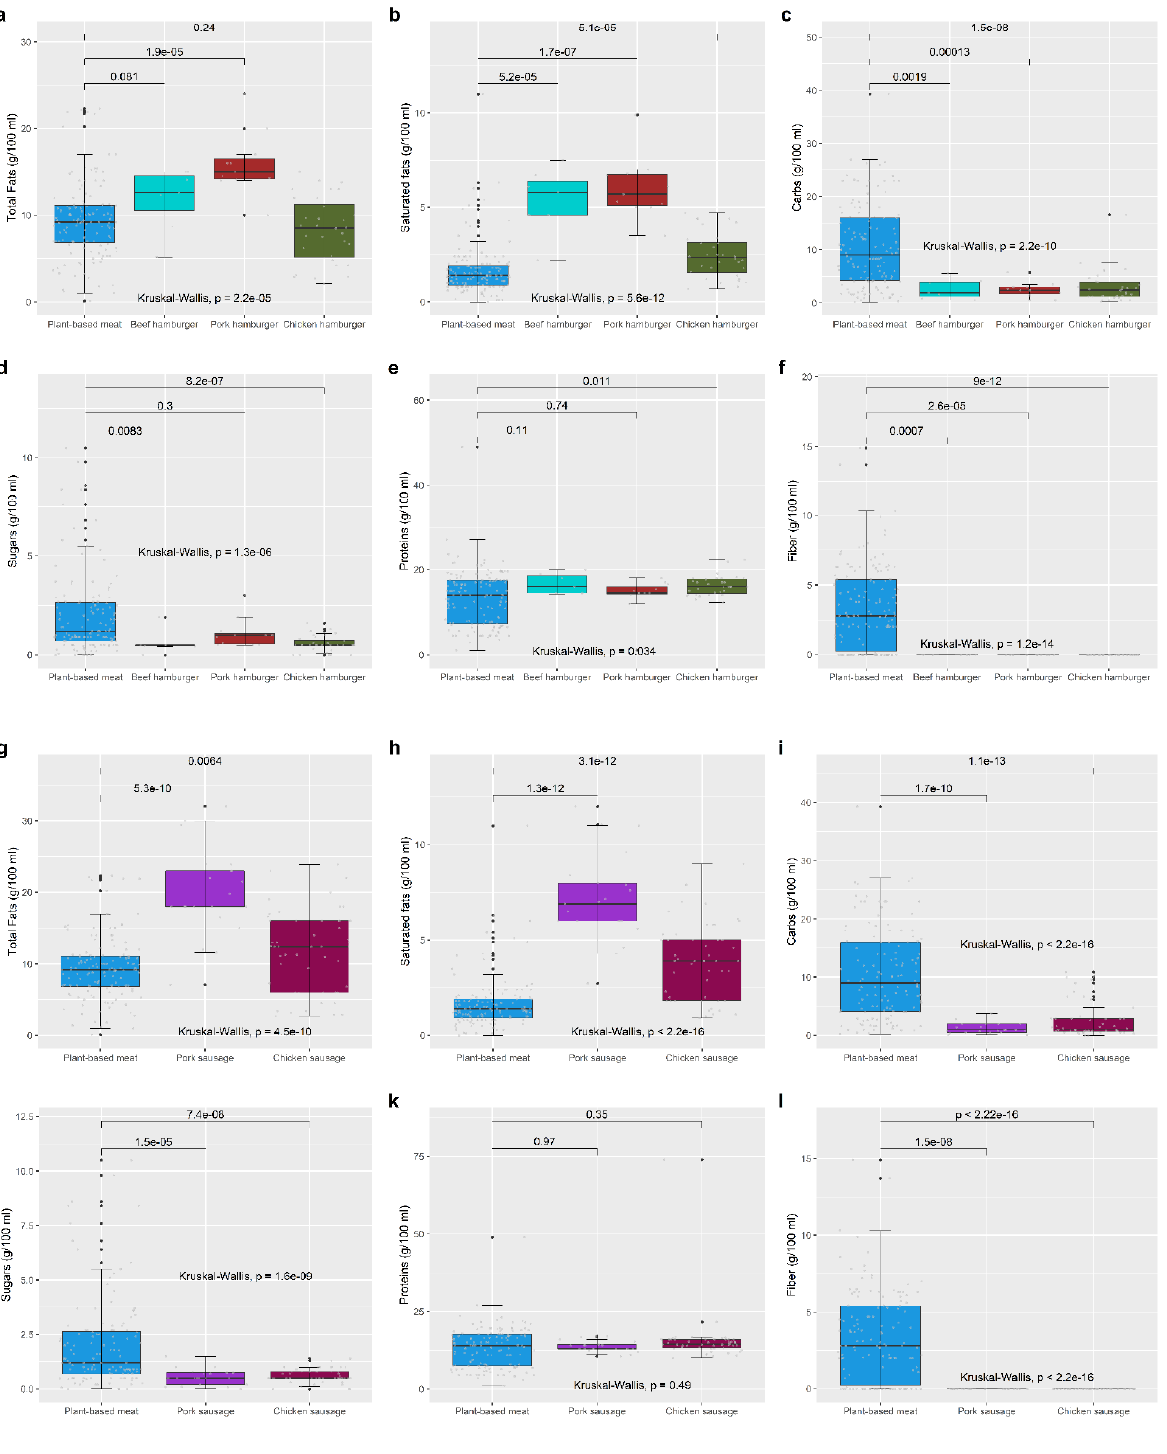
Figure 3. Boxplots of the nutrient composition, per 100 g of AB meats (burger and sausages) and PB alternatives. PB “meat” (blue colour) is compared with AB meat products (beef burger in light blue, pork burger in red, chicken burger in green, pork sausage in purple, and chicken sausage in magenta colour). For both hamburgers and sausages, the nutrient composition is shown for total fats ( a , g respectively) and saturated fats content ( b , h , respectively), carbs ( c , i , respectively) and sugars content ( d , j , respectively), proteins ( e , k , respectively), and fiber ( f , l , respectively), relative to 100 g meat. p -values are derived from Wilcoxon test (between two groups) and from Kruskal–Wallis tests (between more than two